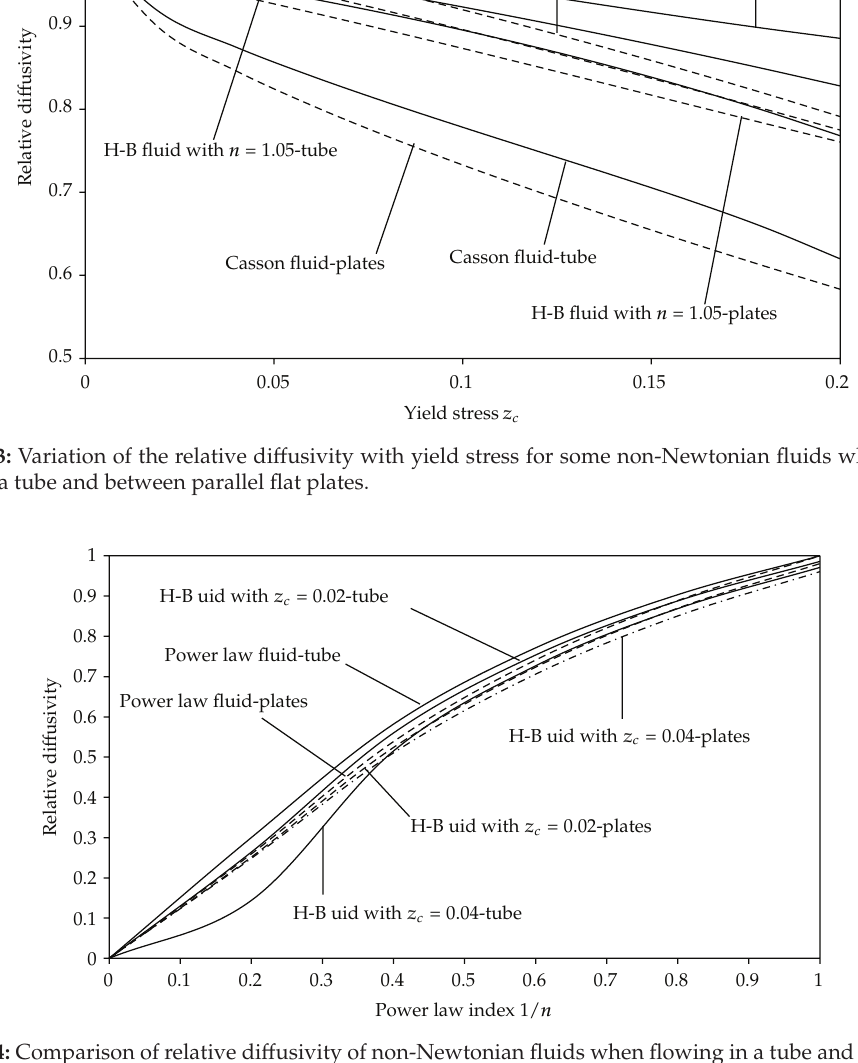
Figure 4: Comparison of relative di ff usivity of non-Newtonian fluids when flowing in a tube and between parallel flat